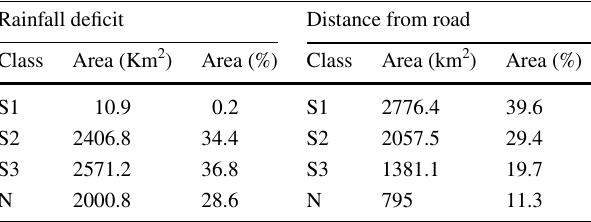
Table 12 Areal distribution of rainfall deficit and proximity to the road suitability classes